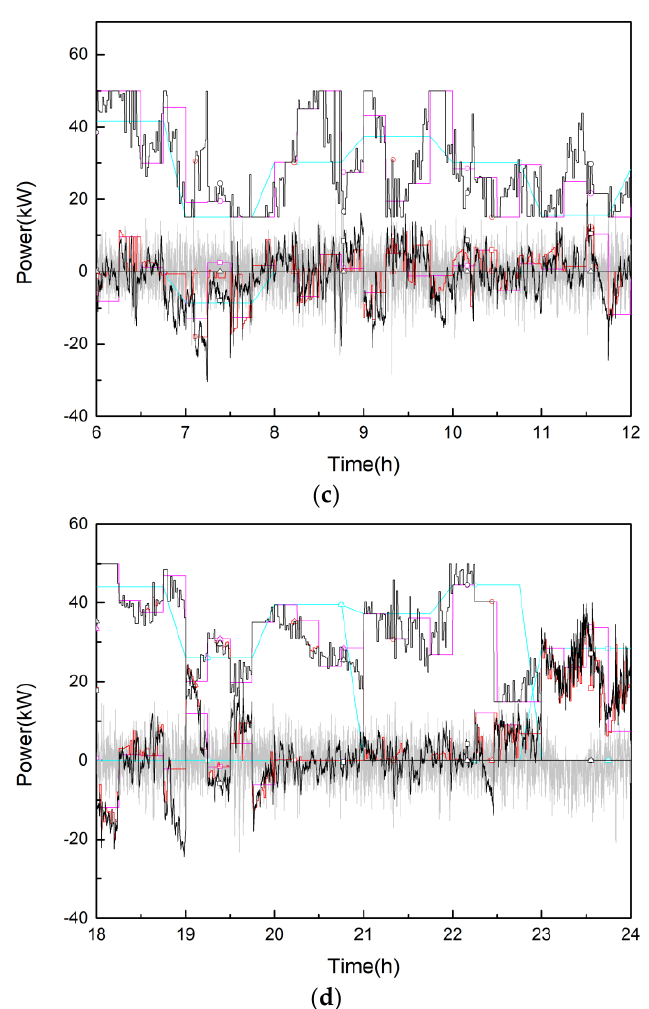
Figure 6. Test results of multi-timescale coordinated control. ( a ) Results of 0–6h. ( b ) Results of 6–12h. ( c ) Results of 12–18h. ( d ) Results of 18–24h.